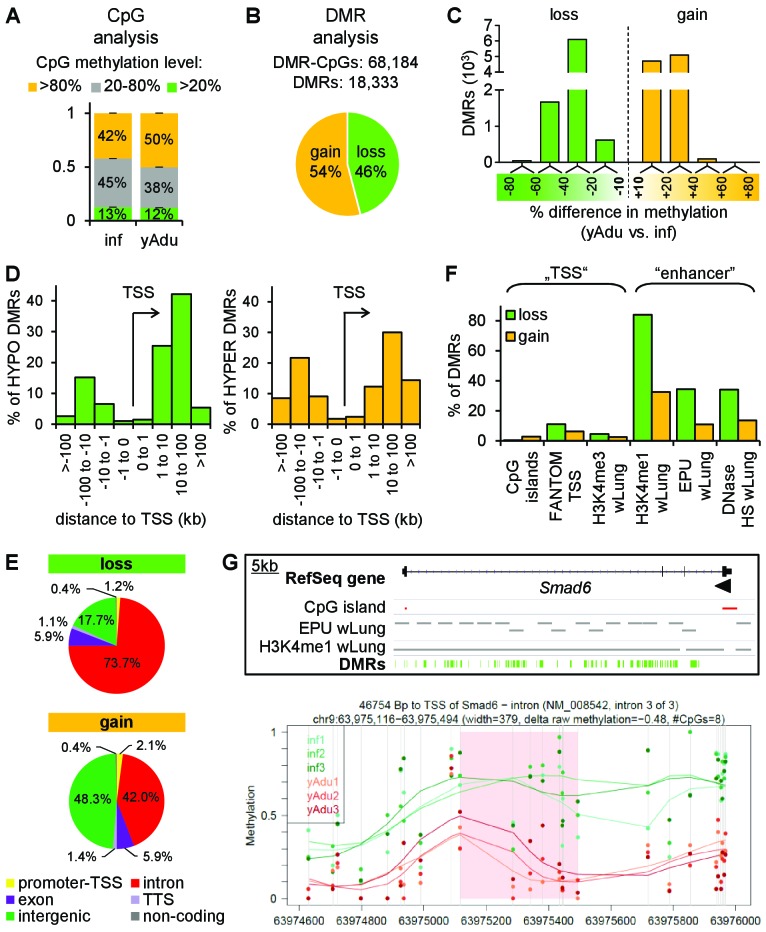
Vascular quiescence is accompanied by a prominent loss of DNA methylation at intronic enhancer regions.(A, B) Data of tagmentation-based WGBS of infant and young adult lung EC were analyzed on the level of single CpGs (A) and differentially methylated regions (DMRs) (B). (C) Distribution of the methylation difference (in %) of DMRs during the acquisition of EC quiescence. Depicted are all changes ≥ 10% between young adult and infant EC. (D) Localization of hypo- (left) and hyper- (right) methylated DMRs relative to the transcription start site (TSS) in kb. (E) Genomic location of the hypo- (top) and hyper- (bottom) methylated DMRs. TTS = transcription termination site. (F) Overlap analysis of DMRs with known regulatory DNA elements of the lung. wLung = whole lung tissue, EPU = enhancer promoter units, HS = hypersensitivity. (G) Top: Genome browser view of the Smad6 gene locus. Green bars represent the DMRs showing significant loss of methylation during the acquisition of vascular quiescence. Arrowhead represents the transcription start site. Grey bars represent putative enhancer regions previously defined. Bottom: Detailed view of one representative DMR (transparent red) showing the raw (dots) and the smoothed (lines) methylation data of EC from three infant (green) and three young adult (red) mice. CpGs are represented by vertical lines. The following figure supplements are available for Figure 3.